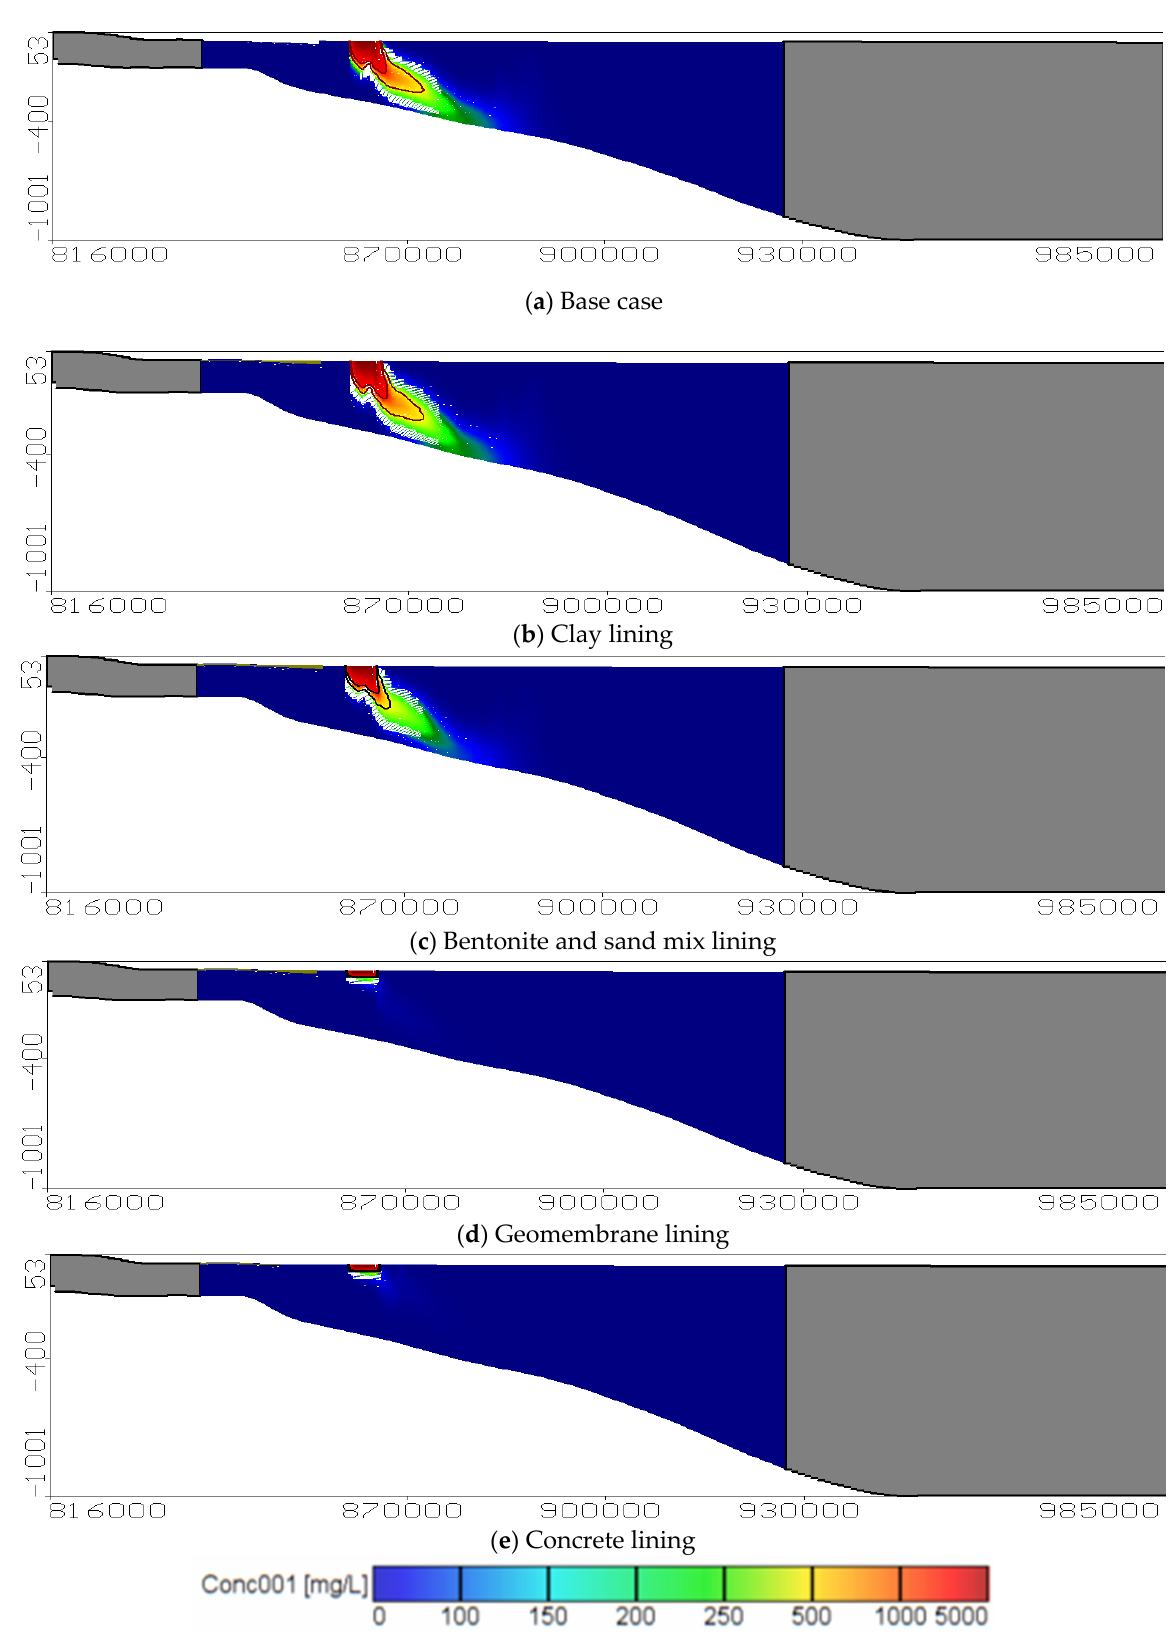
Figure 9. Vertical cross-section for TDS distribution using lining in the X direction of zone B.